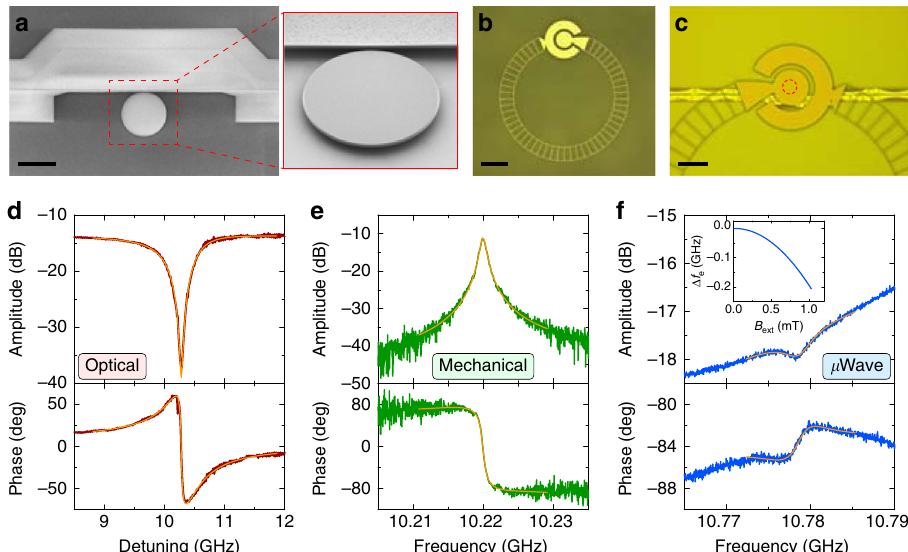
Fig. 2 Device design and characterization. a An SEM image of the AlN piezo-optomechanical micro-disk resonator with a radius of 12 μ m. An angled zoomed-in view of the suspended disk is shown on the right. b An optical image of the frequency-tunable superconducting “ Ouroboros ” microwave resonator fabricated in NbN on sapphire substrate. c An optical image of the integrated device showing the alignment between the “ Ouroboros ” and the micro-disk. The “ Ouroboros ” is fl ipped over with its circular capacitor pad aligned above the micro-disk (indicated in a red dashed circle). Scale bars in a – c are 20, 100, and 50 μ m, respectively. d – f Spectrum of the optical, the mechanical, and the microwave resonances, respectively, with both amplitude and phase response at 900 mK. Orange lines are Lorentzian fi ttings. The detuning in d is from a pump laser at 194.363THz (1543.5 nm). The inset in f shows the resonant frequency tuning of the “ Ouroboros ” under an external magnetic fi eld. The resonance in f is at zero fi